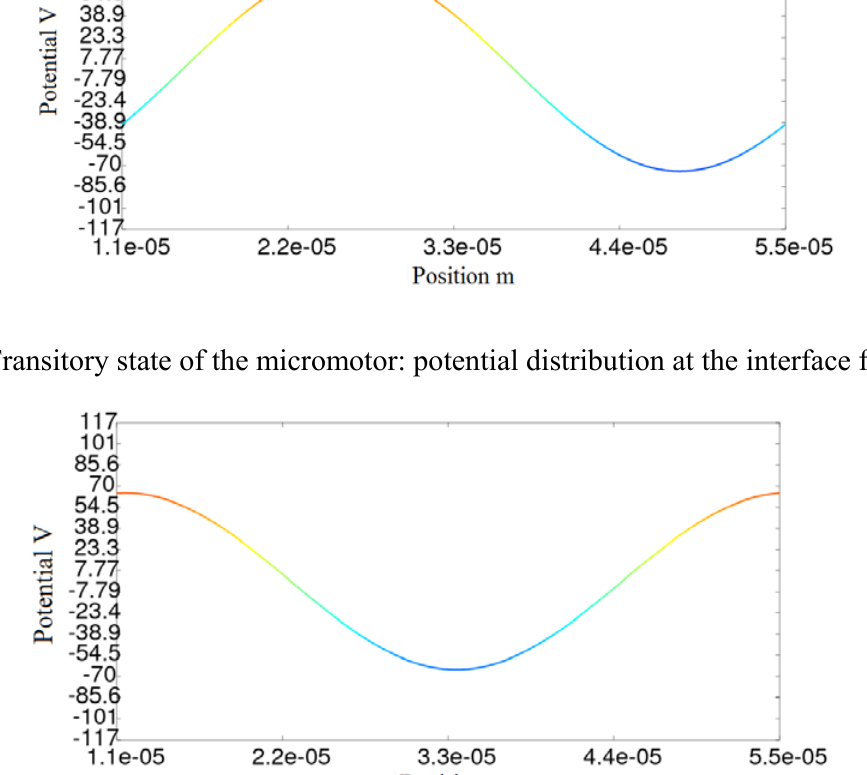
Figure 9. Transitory state of the micromotor: potential distribution at the interface for instant t